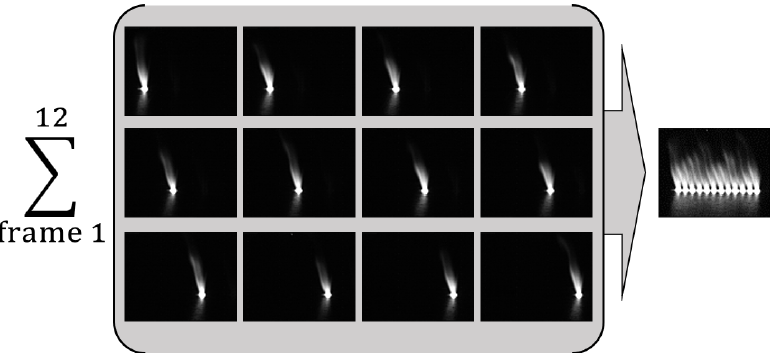
Figure 2. Example of frame superimposition (single track formation at P = 300 W, v = 600 mm/s, recorded at 50 k fps), frame interval used here is 36, which means the time interval between two adjacent frames is 720 µ